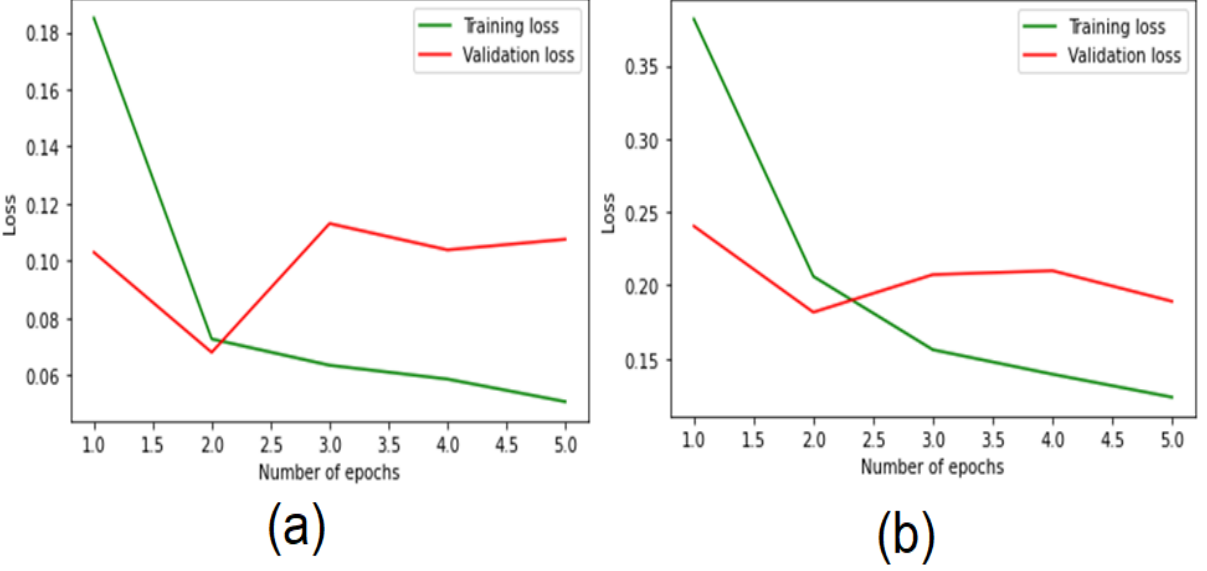
the BiLSTM accuracy loss in testing phase is 0.10% where the CNN-BiLSTM is 20%